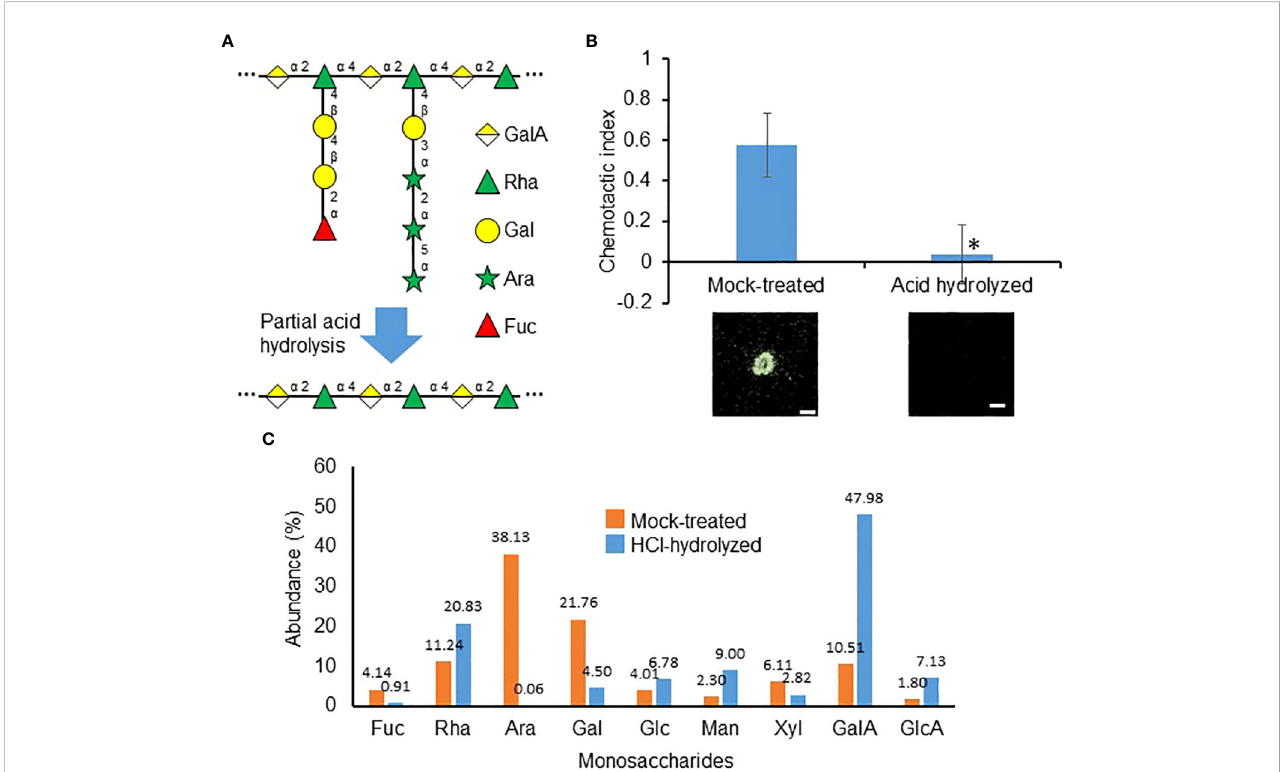
FIGURE 7 Carbohydrate sidechains are important for the puri fi ed attractant. (A) Representative RG-I structure from Figure 4B to depicting the theoretical loss of sidechains during partial acid hydrolysis. (B) RKN chemotactic indexes of attractant puri fi ed from SR culture media partially hydrolyzed with HCl. Averages from n = 3 ± SD are shown. *denotes signi fi cant differences from mock-treated samples, P<0.05, student ’ s T-test. Bottom panels show representative RKN behavior in the presence of the attractant, scale bars = 1 mm. (C) . Relative abundances of monosaccharides detected in mock- treated and HCl-hydrolyzed puri fi ed attractants. Numbers denote the numerical values of fucose (Fuc), rhamnose (Rha), arabinose (Ara), galactose (Gal), glucose (Glc), mannose (Man), xylose (Xyl), galacturonic acid (GalA), and glucuronic acid